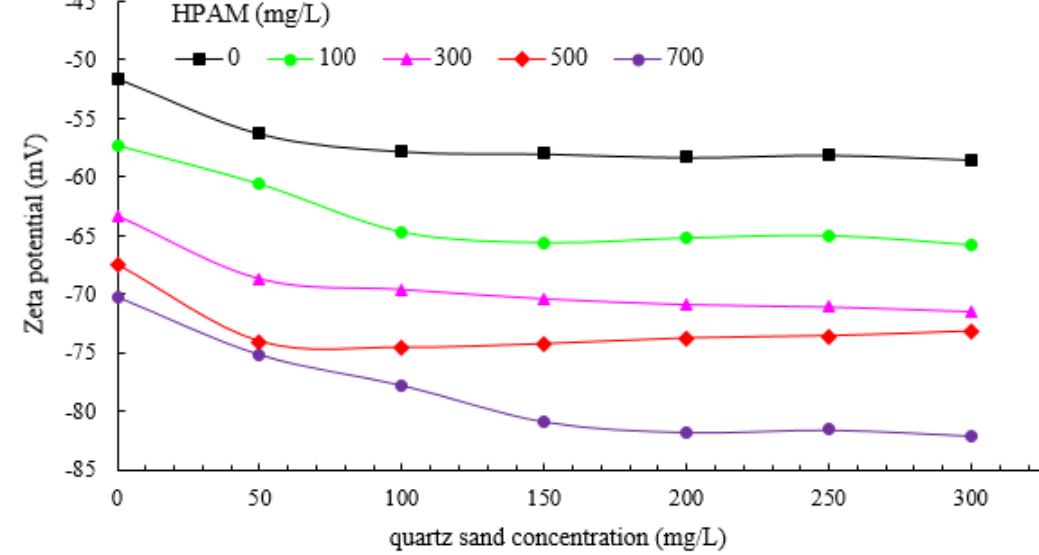
Figure 8. The synergetic effect of polymer and quartz sand particles on Zeta potential (alkali concentration 600 mg/L, surfactant concentration 200 mg/L).